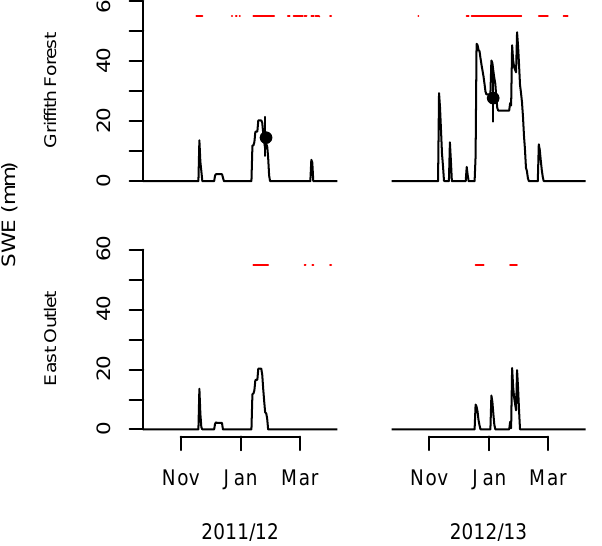
Fig. 8. Comparison of modelled and observed snow cover, and mea- sured snow water equivalence from the forested area of Griffith Creek (430m elevation), and modelled SWE and observed snow cover at the East Creek outlet (291m elevation), from October to April for 2011/2012 and 2012/2013. Red horizontal lines indicate periods of snow cover determined from the time-lapse cameras. The black points are mean snow water equivalent (with standard error) from manual snow surveys conducted at the forested site at Griffith Creek.